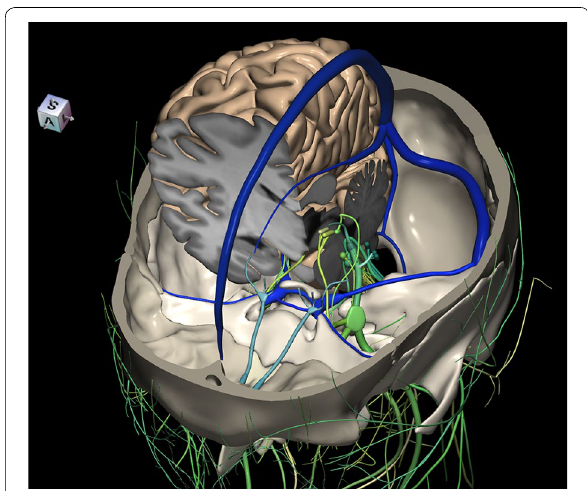
Fig. 7 Skull base with an anteriorly dissected right hemisphere, cranial nerves with nuclei and dural sinuses